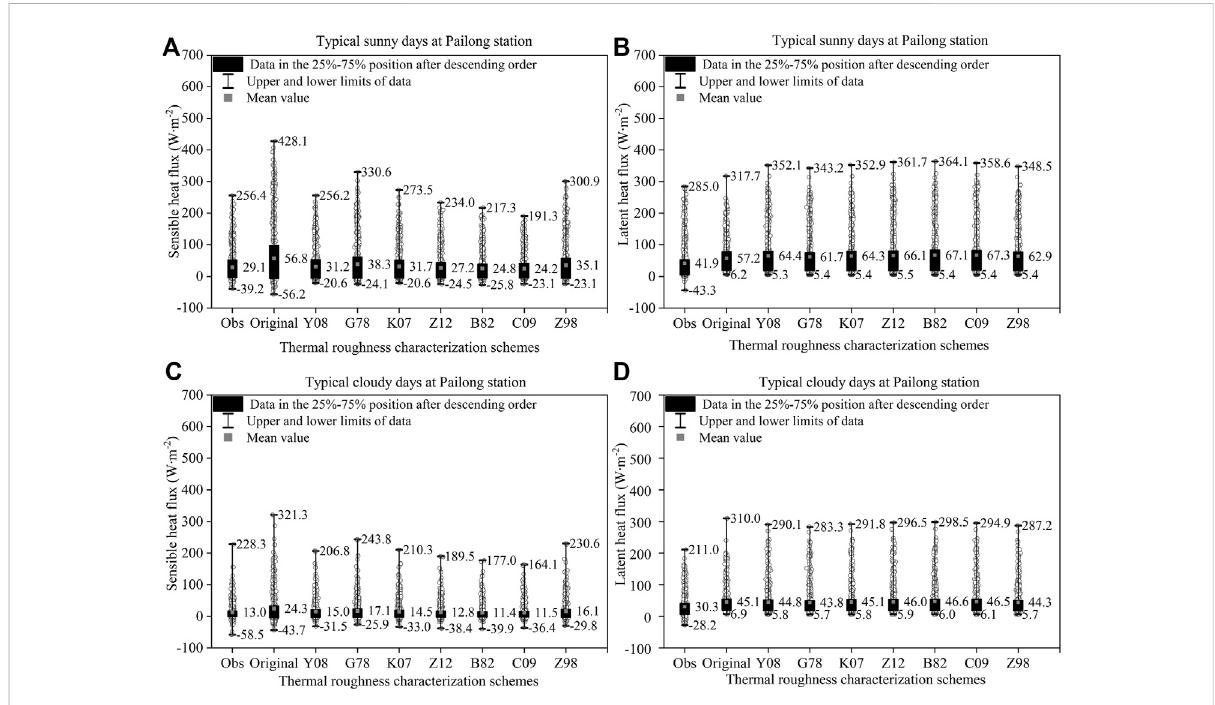
FIGURE 10 Boxplots of the observations and the simulations of H and LE under different Z 0h schemes on typical sunny/cloudy days at Pailong station, (A and C) H, (B and D) LE, unit: (W · m − 2